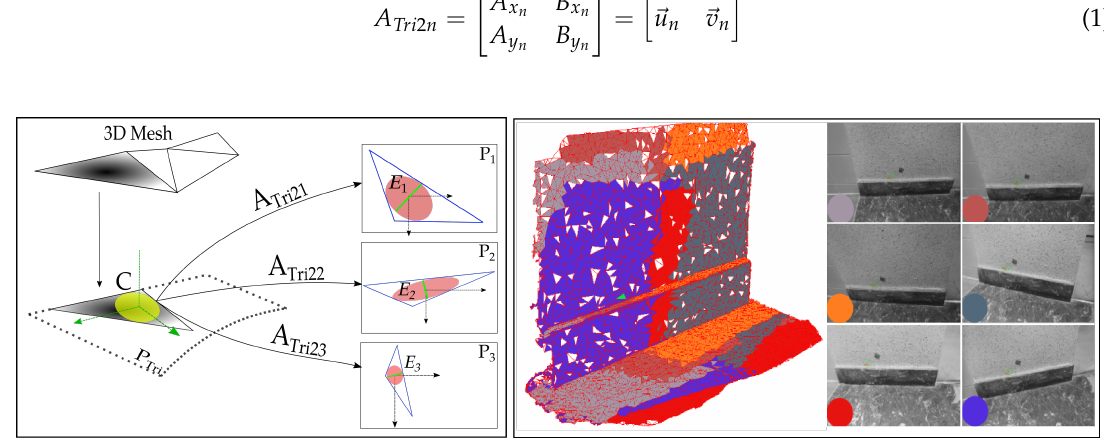
Figure 5. Optimal resolution condition in the selection of master image and scene partition. ( Left ): tensor ellipse in images. P 1 will be chosen as master image. ( Right ): Scene partition between 6 master images in a dataset. Each color presents a corresponding scene part with each master